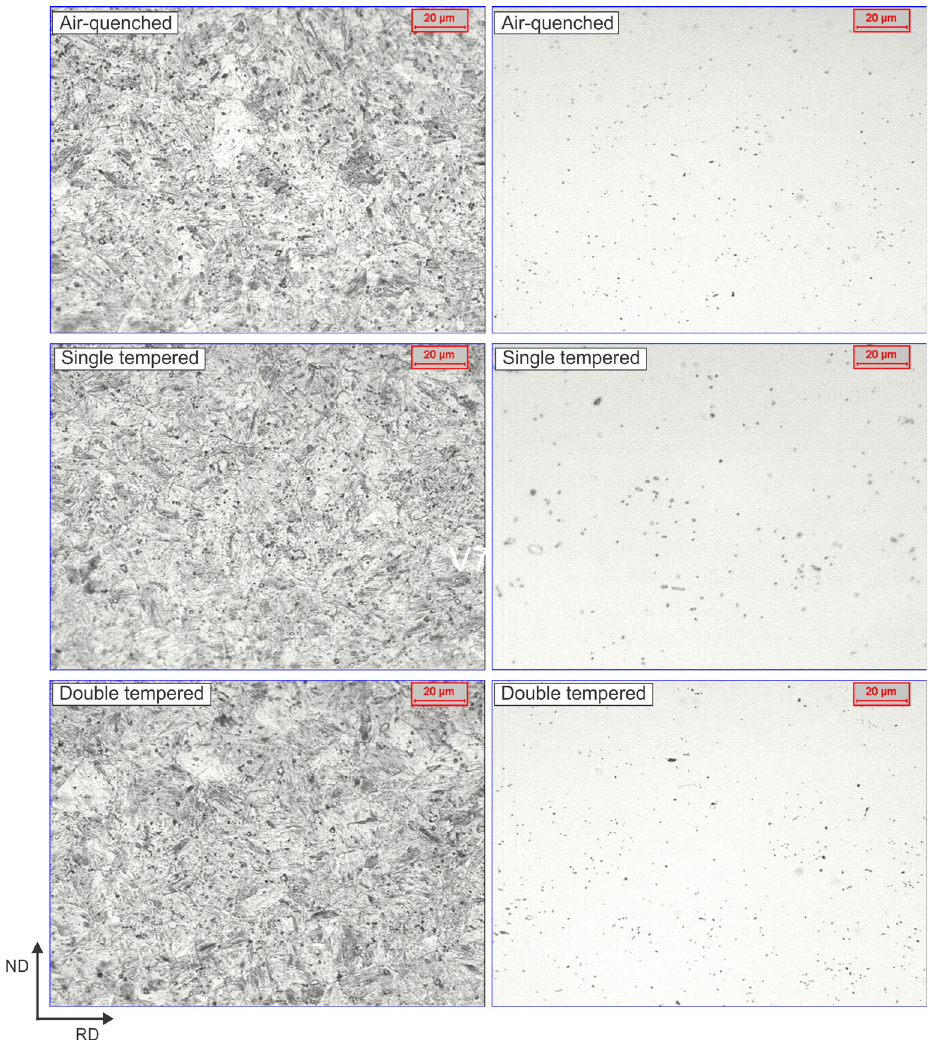
Figure 1. Microstructure of the samples after air-quenching, single tempering and double tempering treatments. Left-hand side: Villela etching. Right-hand side: Groesbecker